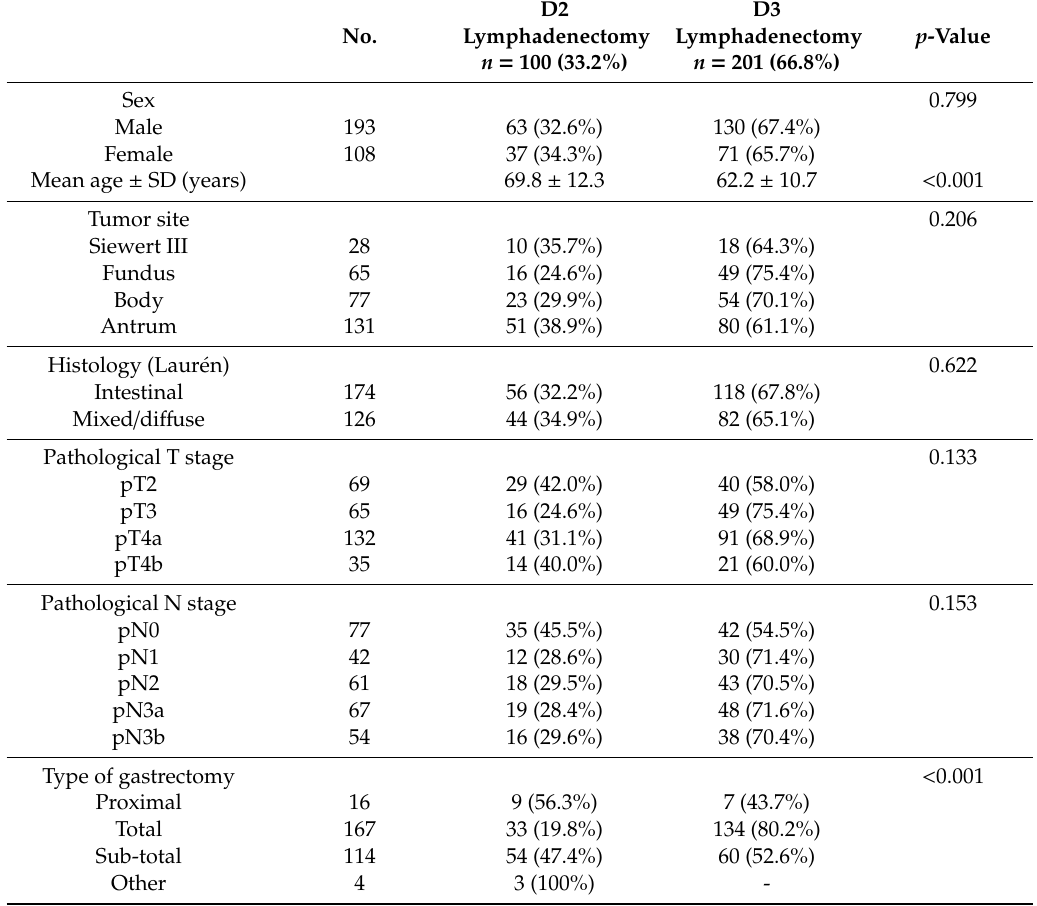
Table 1. Main demographic and clinical characteristics of the patients at the baseline. The bold highlights the significant differences.